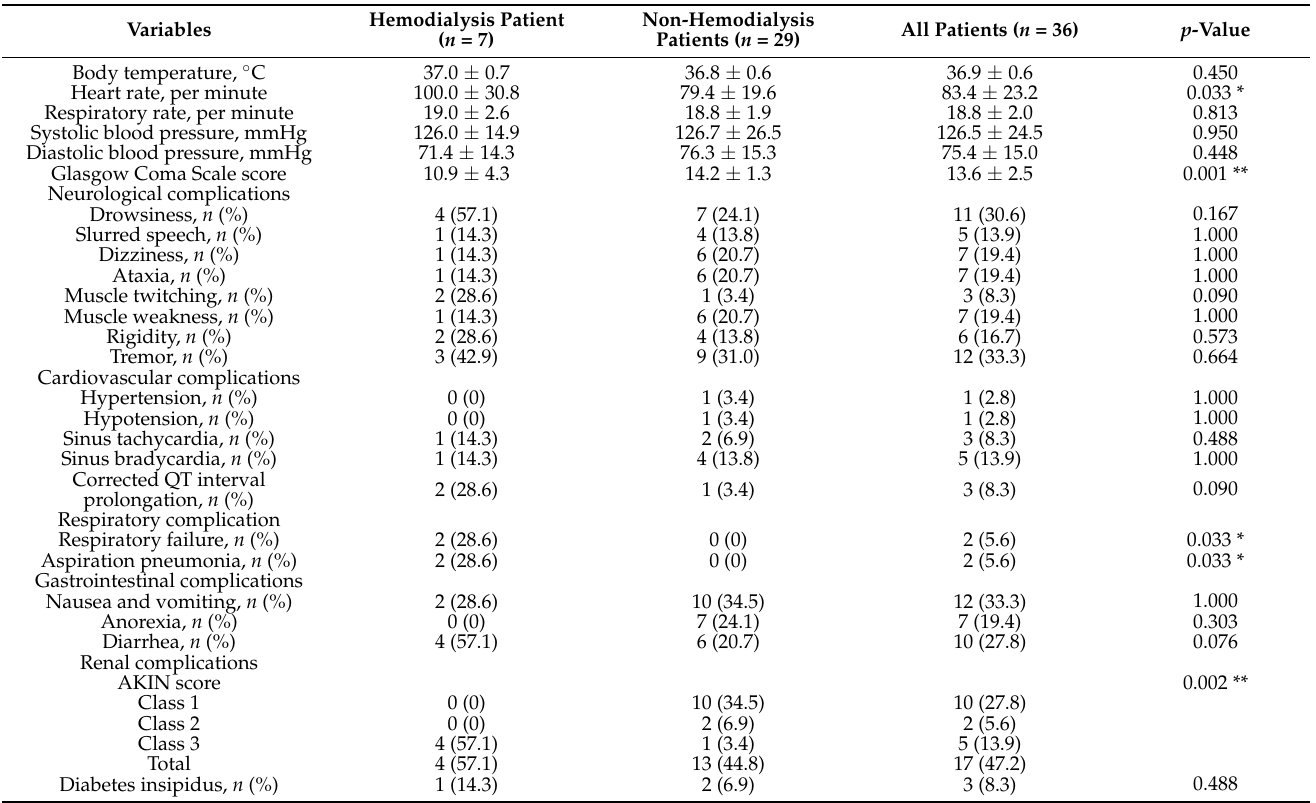
Table 4. Clinical manifestations of patients with lithium poisoning, stratified according to whether they were treated with hemodialysis or not ( n =